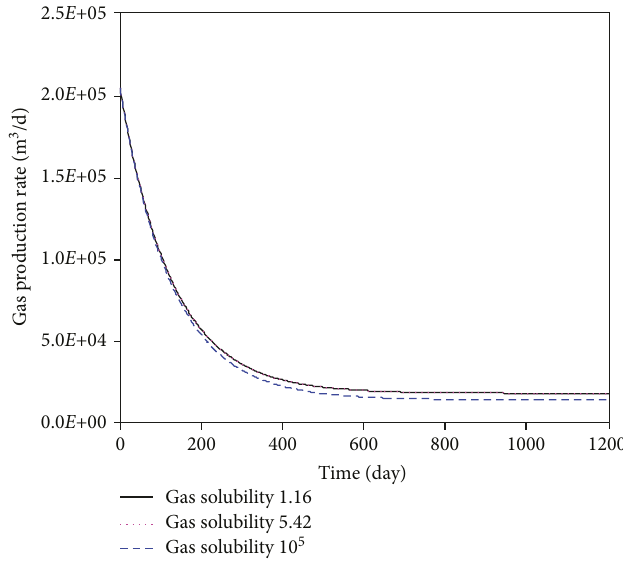
Figure 7: Impact of gas solubility on the gas production rate.